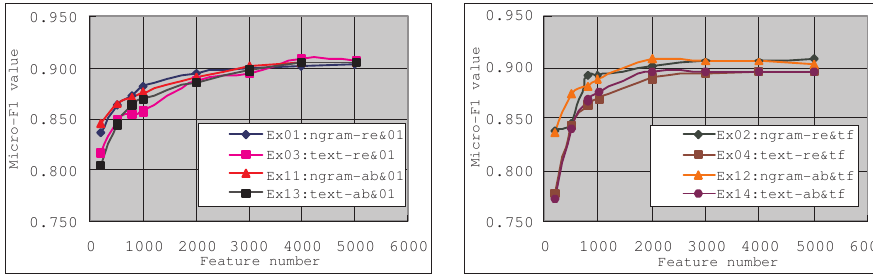
Fig. 1. Performance comparison on four kinds of feature selection methods (on C-SVC